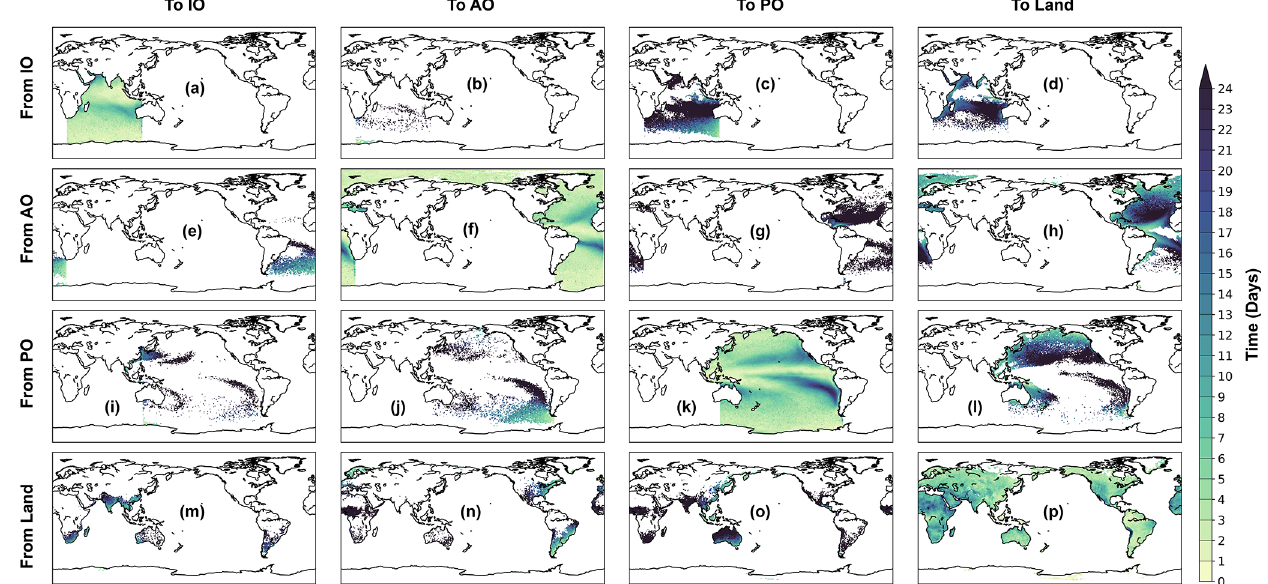
Figure 6. The average residence time (days) of the atmospheric waters mapped on their net evaporative points within and between the three ocean basins and land. Note that this has been mapped where the net evaporation exceeds a monthly mean value of 0.2mmd − 1 . The residence time has been calculated from the time the trajectories have spent in the atmosphere between their starting (net evaporation) and ending (net precipitation)